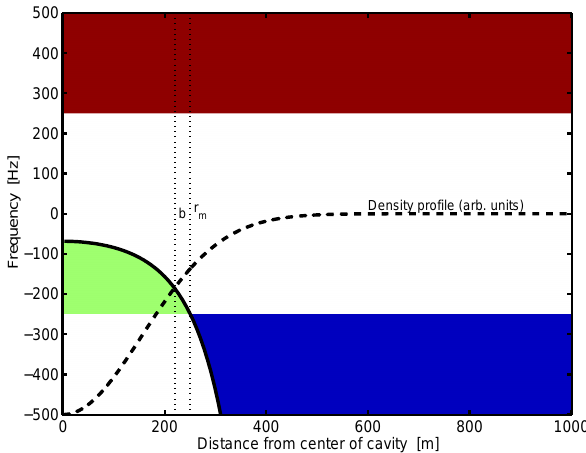
Fig. 2. The coloured areas show the wave frequencies we theoreti- cally may find on different distances from the center of the cavity. In this example we have a density depletion with Gaussian shape as in Eq. (38), with f ce = 11kHz, f LH = 250Hz, 1 = 0 . 35, b = 220m and k z = 3 × 10 − 4 m − 1 . A positive frequency corresponds to waves rotating in the right-handed direction, while negative frequencies indicate left-handed rotation. The solid black line is the limiting frequency, ω m /( 2 π) . The density profile is included for compari-